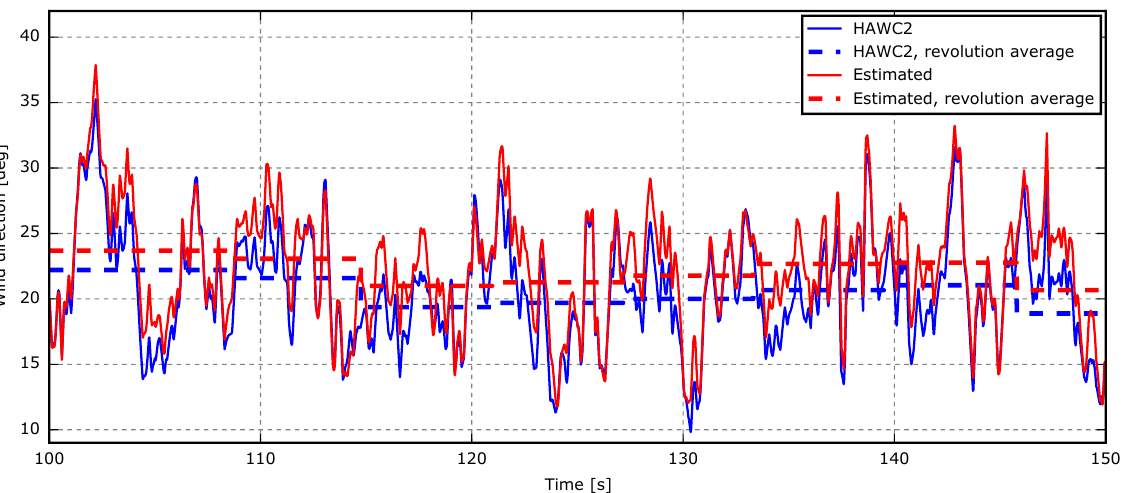
Figure 17. HAWC2 results including the wind direction derived from estimated free wind speed and HAWC2 reference in a simulation with 20 ◦ yaw